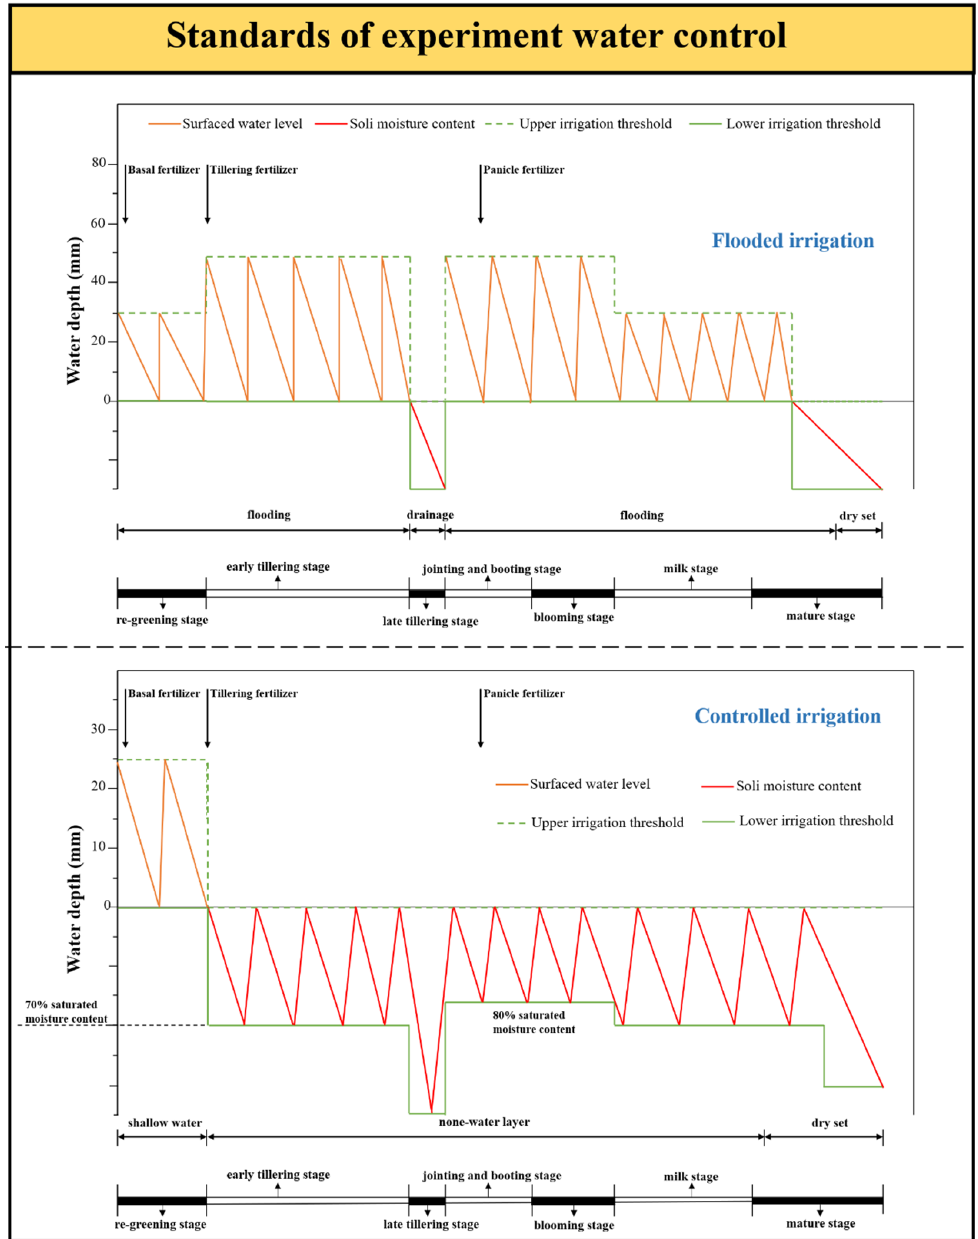
Figure 2. Standards of experiment water control under flooded irrigation and controlled